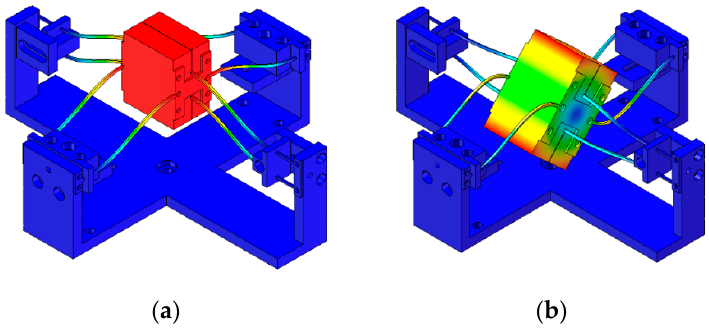
( b ) Figure 13. Mode shapes of TMD2. ( a ) The 1st mode; ( b ) the 2nd mode. Table 5. Calculation results of 2DOFs TMDs. TMD